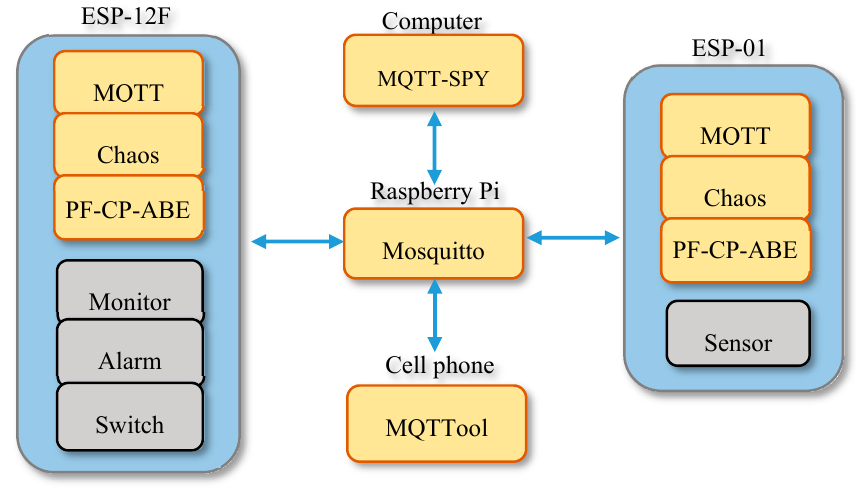
Figure 5. System Figure 5. System architecture.